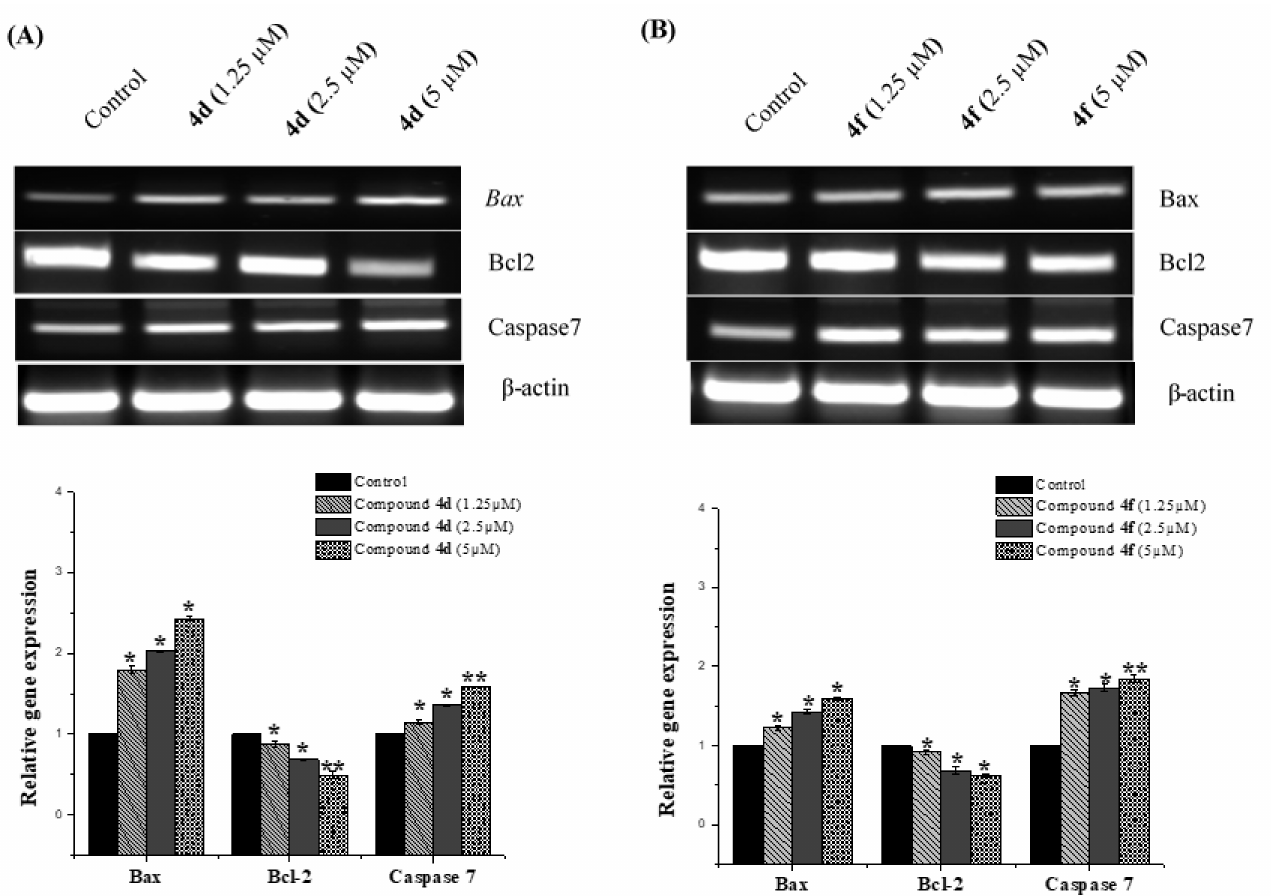
Figure 6. RT-PCR analysis of apoptotic related genes. The RT-PCR expression profile of Bax, Bcl2